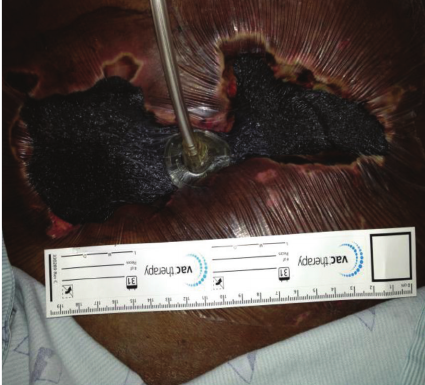
Figure 6: Wound vac after debridement for further